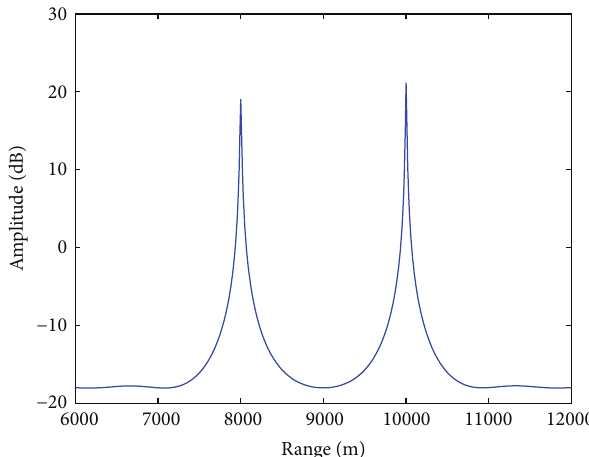
Figure 5: Power spectra profile for FDA MIMO radar in range dimension for angle 20 ∘ .